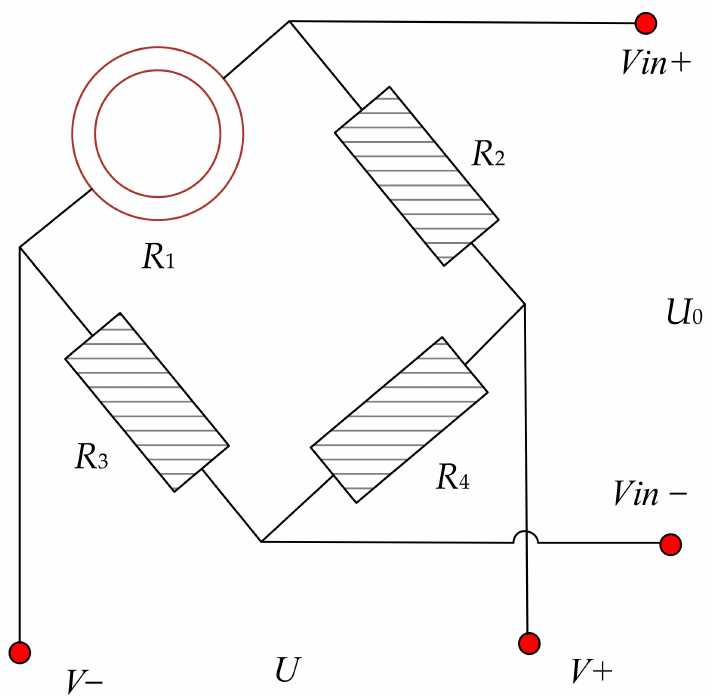
Figure 6. Eddy current signal extraction